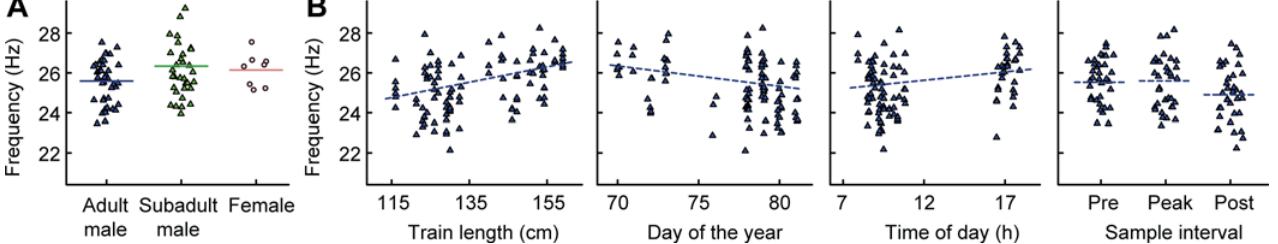
Fig 3. Peafowl feather vibration frequencies during displays in relation to (A) sex, age, and (B) other factors that predict feather vibration frequencies in adult males. (A) Displaying peafowl vibrate their feathers at frequencies ranging from ~22 – 30 Hz, with broad overlap in the ranges of frequencies used by different sex and age classes. Horizontal lines in A are grand means. Dashed lines in B are fits from the linear mixed effects models described in section 3.3. doi:10.1371/journal.pone.0152759.g003 PLOS ONE | DOI:10.1371/journal.pone.0152759 April 27,